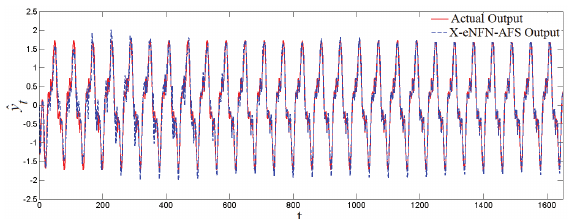
Figure 6. Nonlinear system identification.